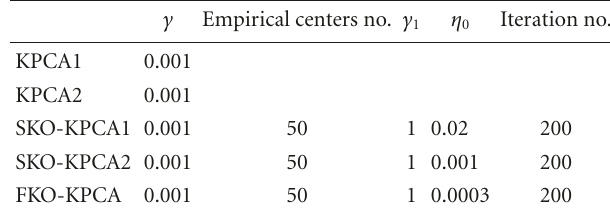
Table 2: The parameters in the